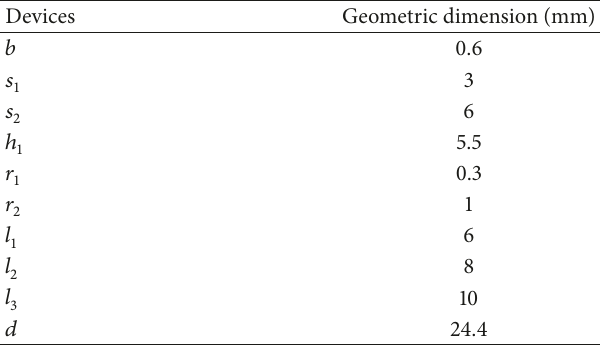
Table 2: Dimensions of resonators.